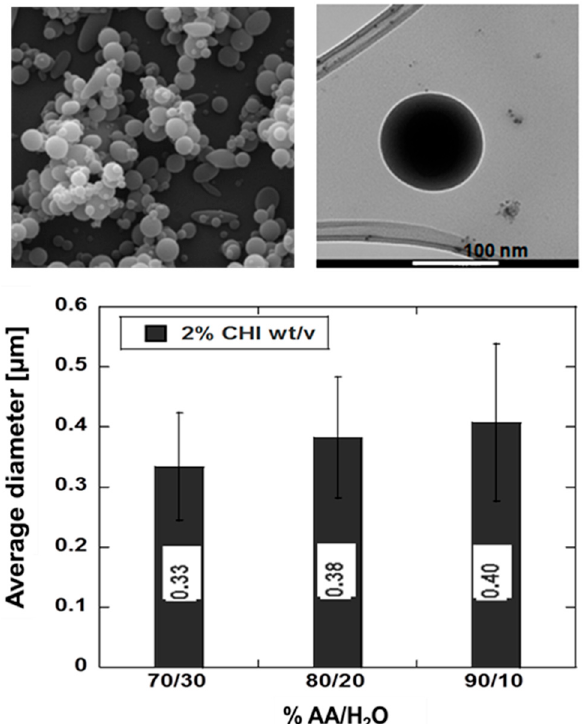
Figure 3. Chitosan nanoparticles fabricated via EDS: morphological analyses by SEM and TEM, and particle size measurement via image analysis as a function of acetic acid/water (AA/H 2 O) ratio.